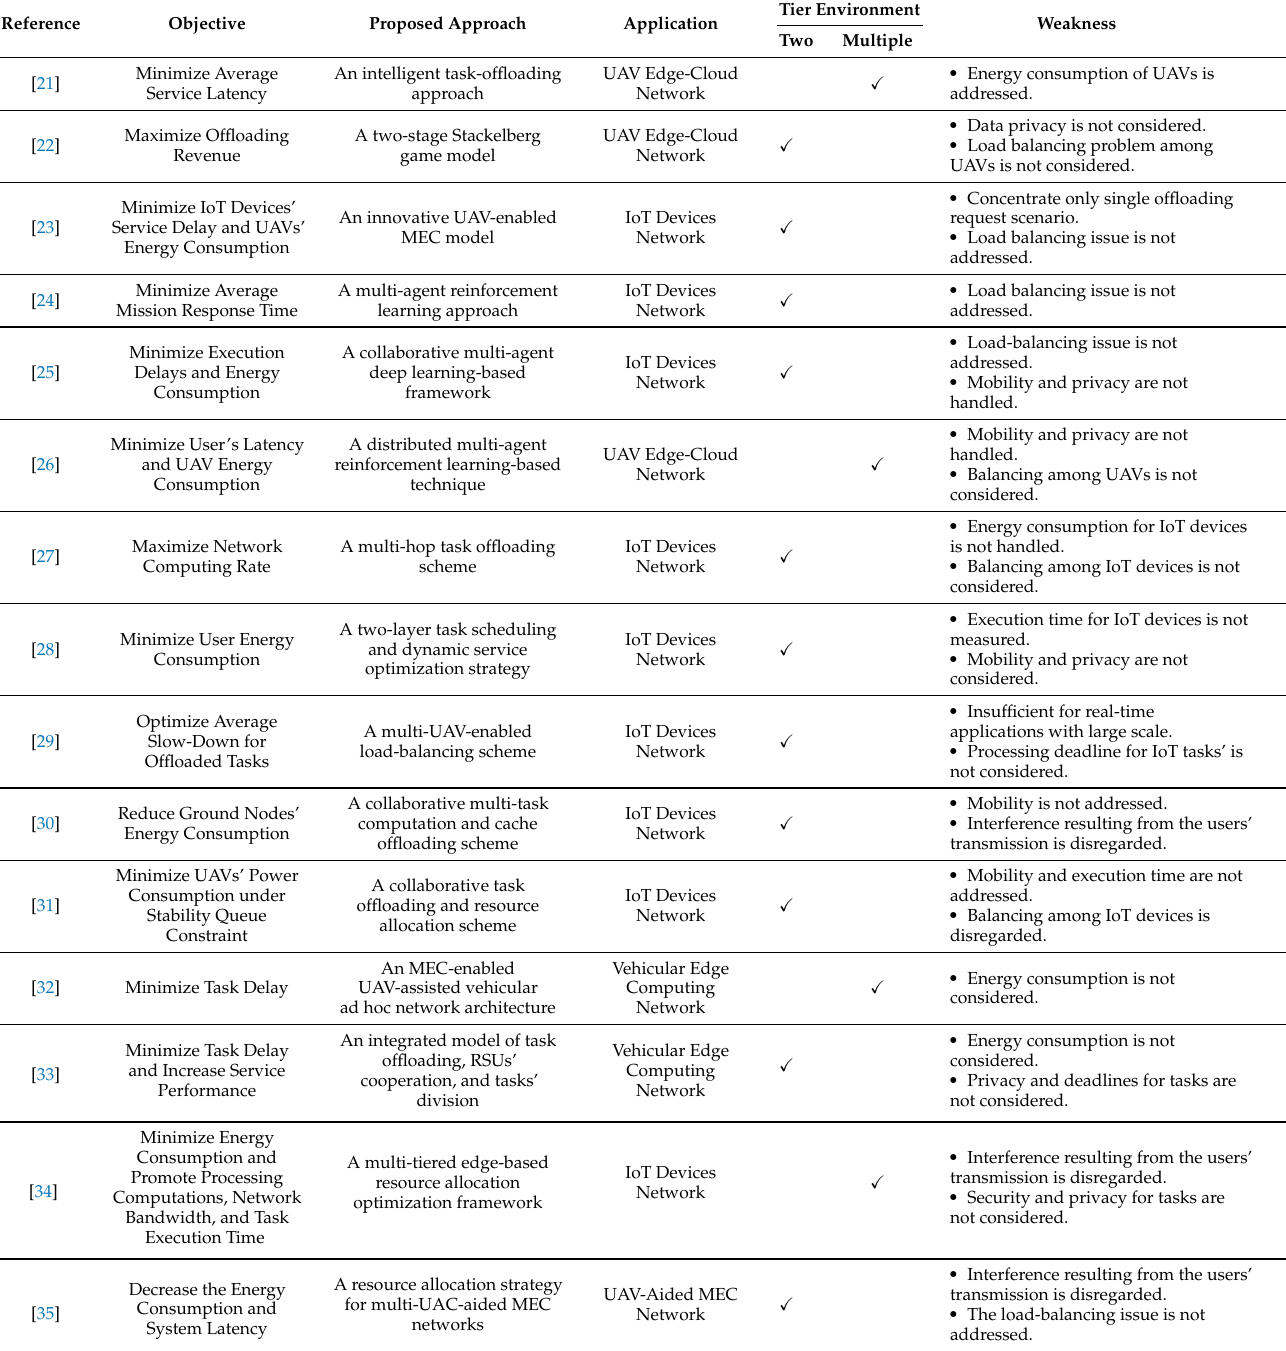
Table 1. A related work